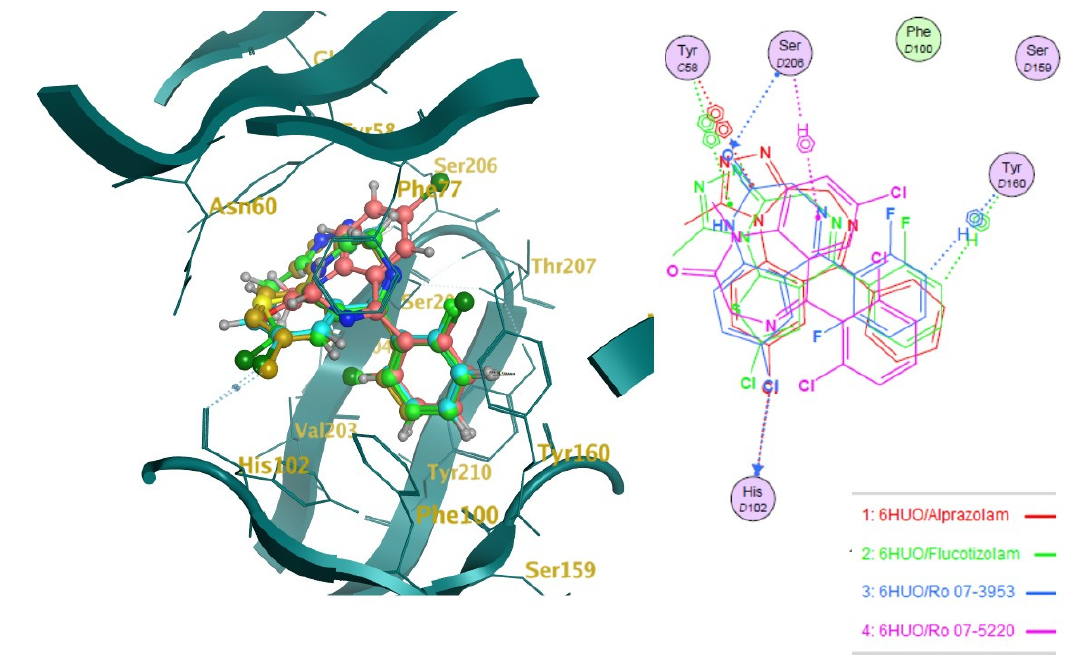
Figure 6. Docking studies on 6HUO [61] binding pocket. Notes: on the left side, the 3D representation of the molecules (Ro 07-3953, Ro 07-5220) docked on the co-crystallised ligand (alprazolam in gold). On the right side is the 2D representation of the ligands’ interactions with the residues of the binding pockets. The dotted lines indicate a hydrogen bond (donor or acceptor according to the direction of the arrow at the end of it) between the ligand and the pocket residues; the dotted lines showing the H and benzene symbol indicate an arene-hydrogen interaction, while the ones showing the two benzene symbolise an arene-arene interaction.